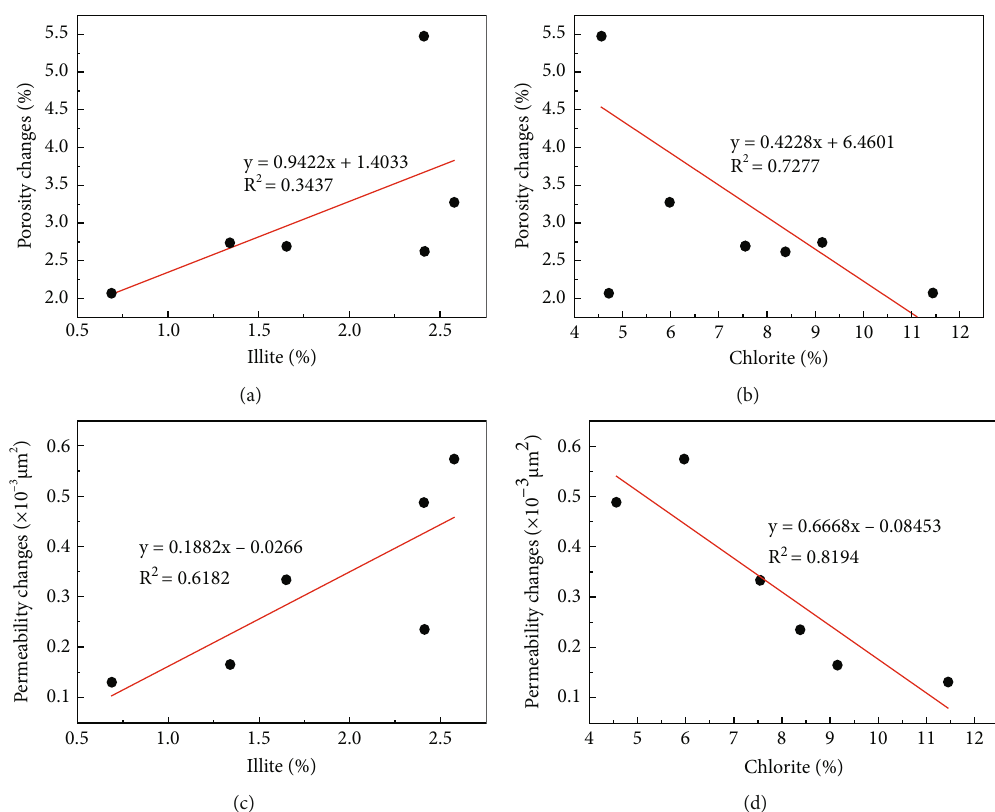
Figure 12: (a) Relationship between illite content and porosity changes. (b) Relationship between chlorite content and porosity changes. (c) Relationship between illite content and permeability changes. (d) Relationship between chlorite content and permeability